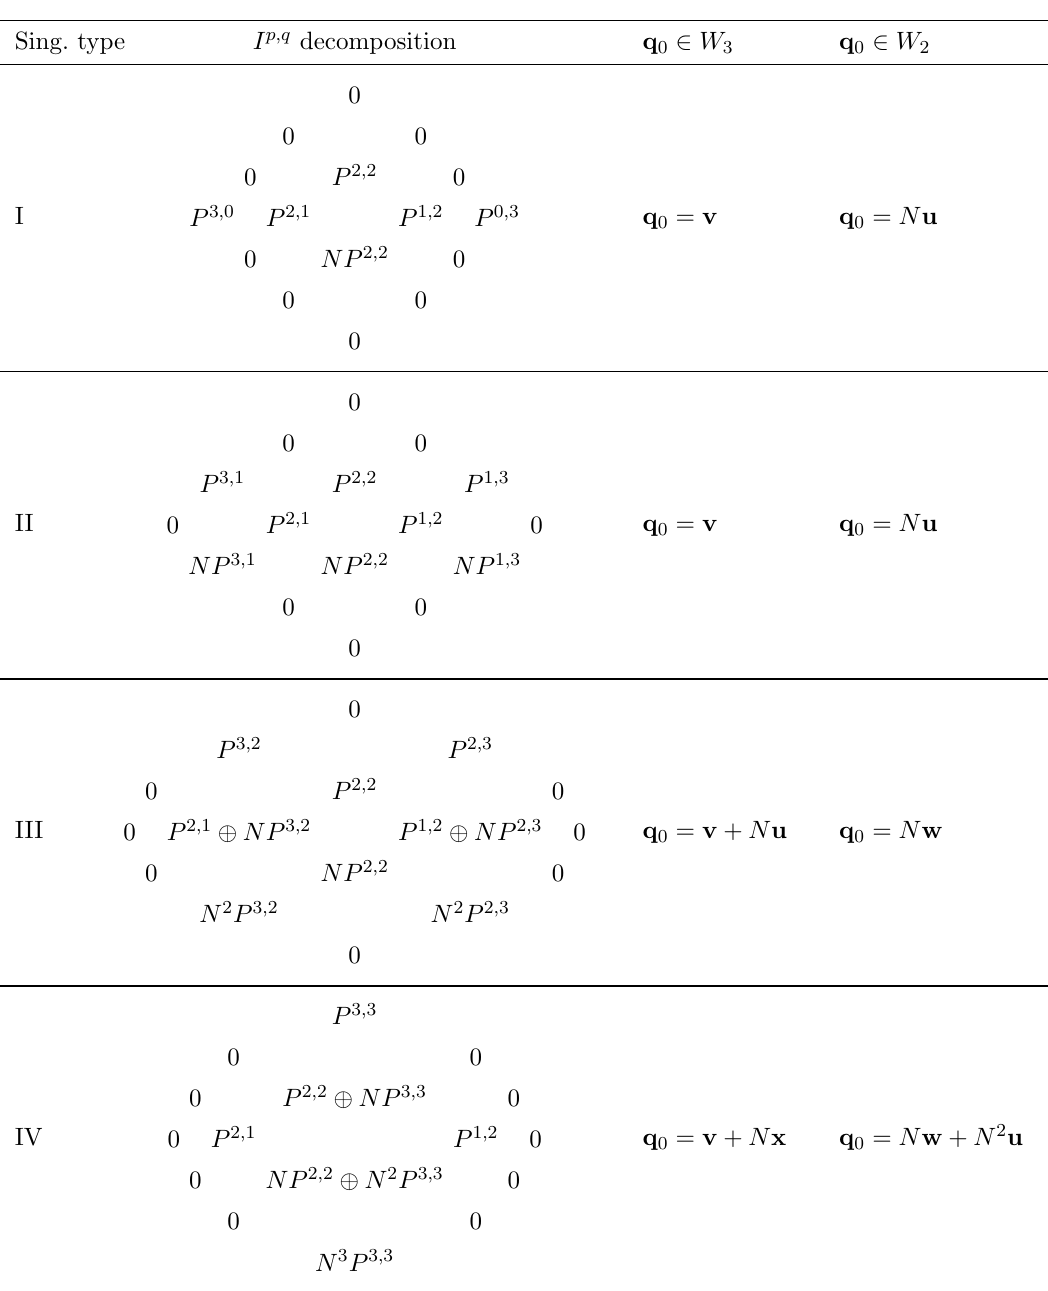
Table 5 . We present for each singularity type the explicit splittings of the I p,q in term of the